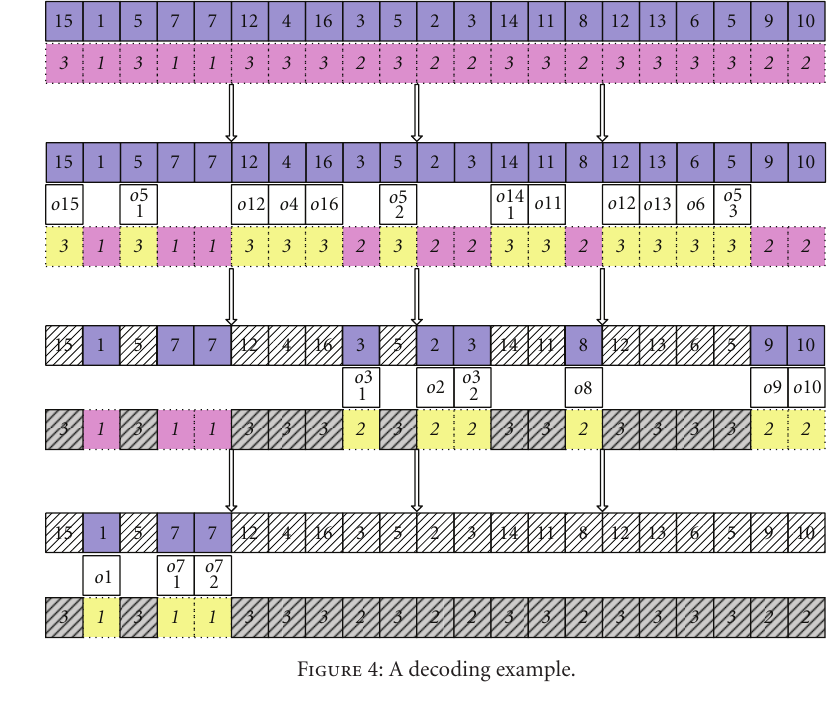
Figure 4: A decoding example.